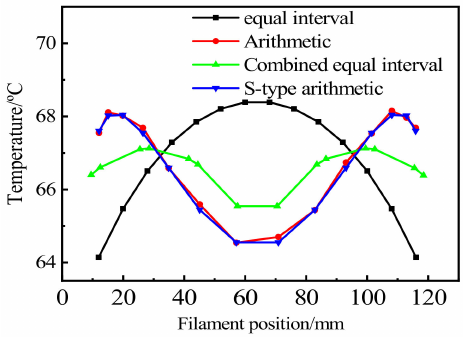
Figure 9. Temperature distribution of the chip.